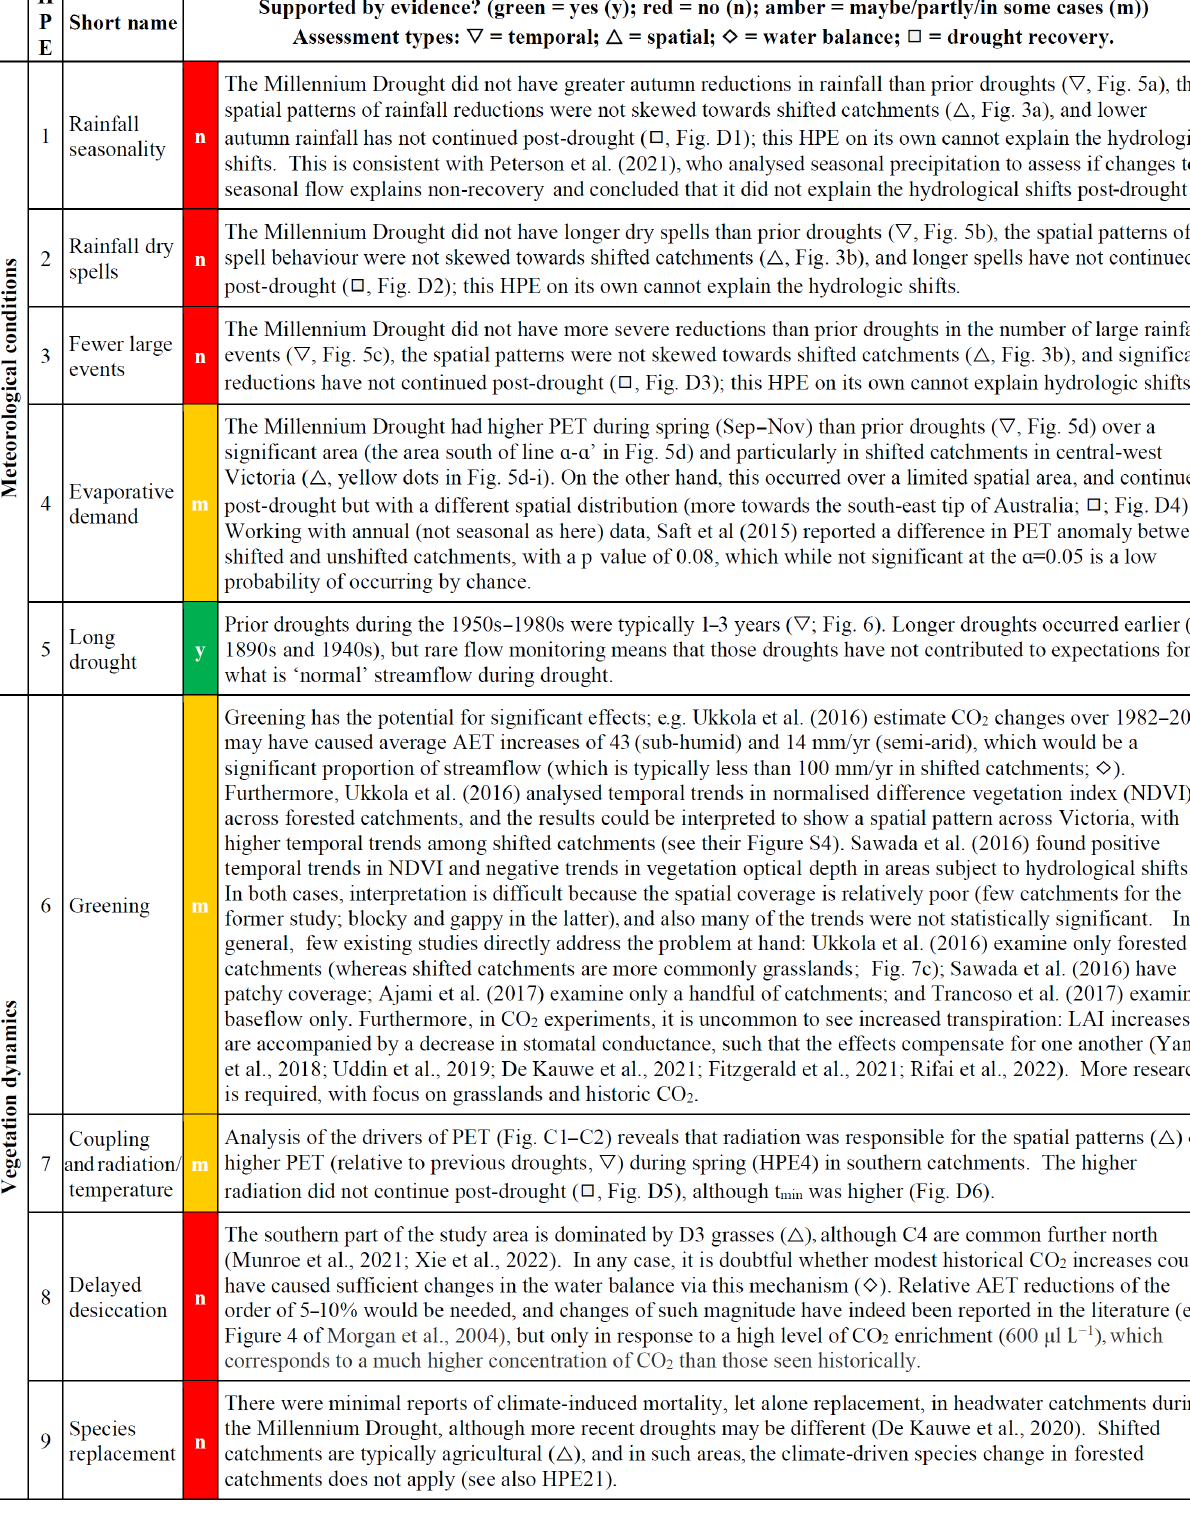
Table 2. Assessment of hypothesised process explanations (HPEs), evaluating consistency with